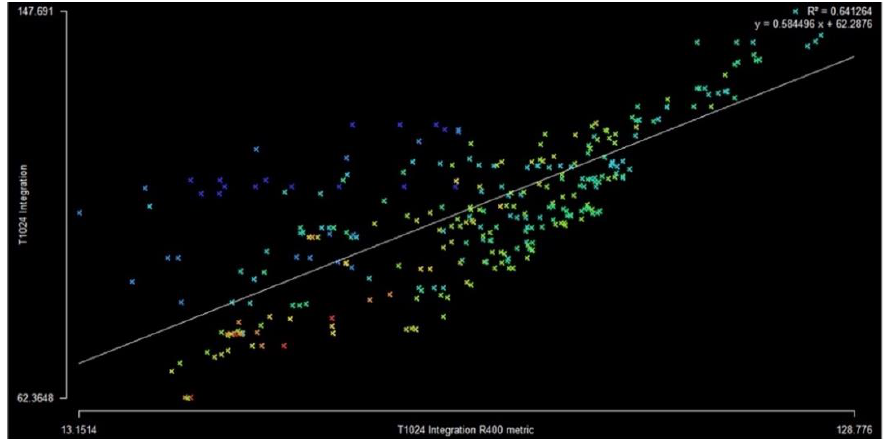
Figure 4. The space syntax model analysis result on Nanyang: intelligibility value.